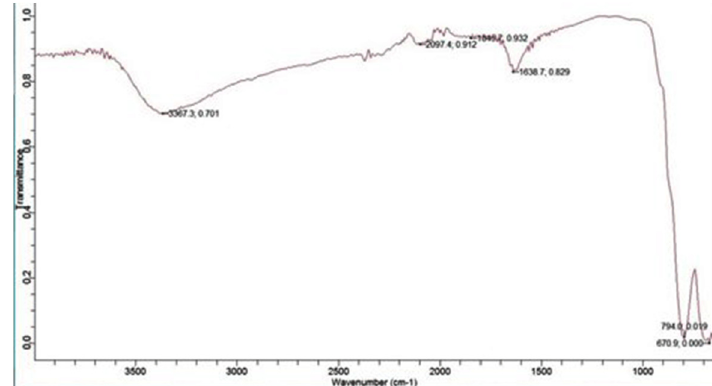
Figure 4. FTIR spectrum of g-C 3 N 4 -MnWO 4.